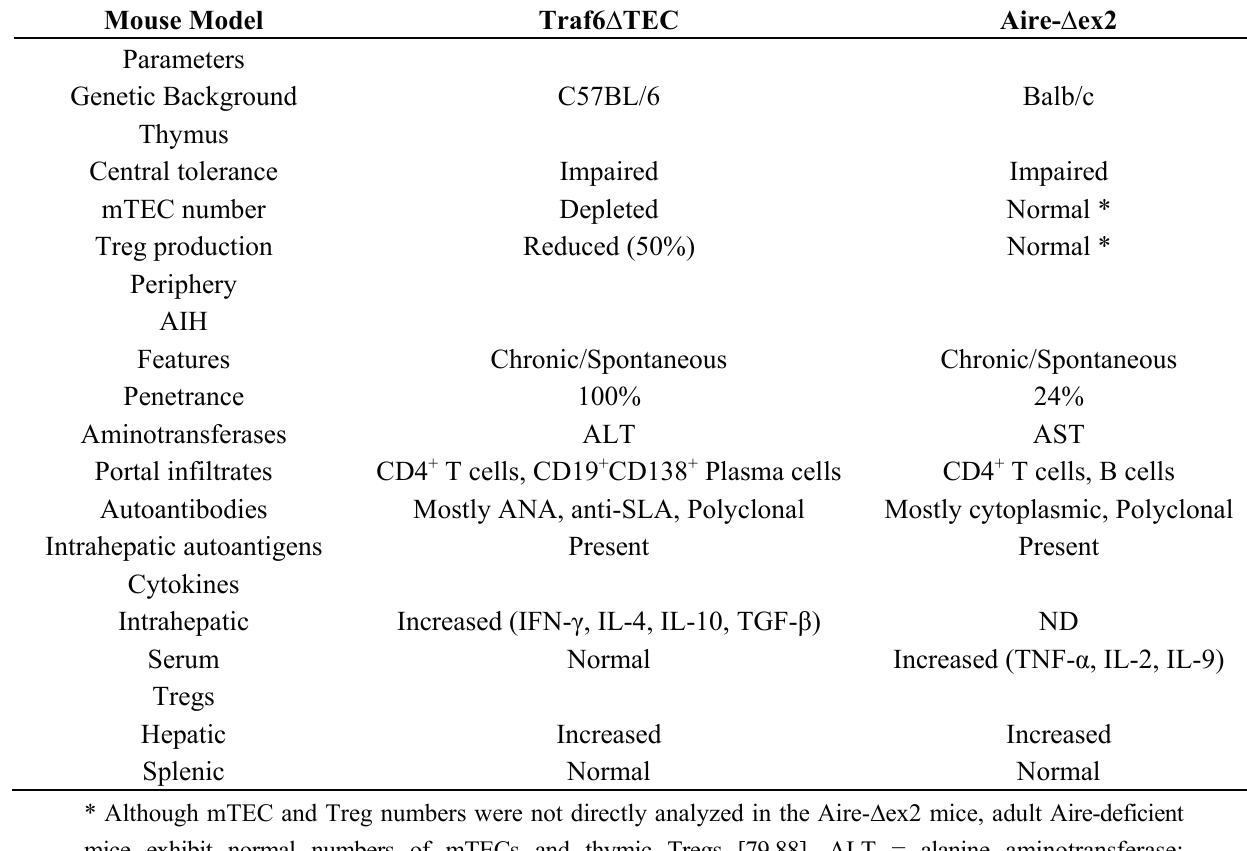
Table 1. Comparison of the phenotypic features of Traf6 ∆ TEC and Aire- ∆ ex2 mouse models. Mouse